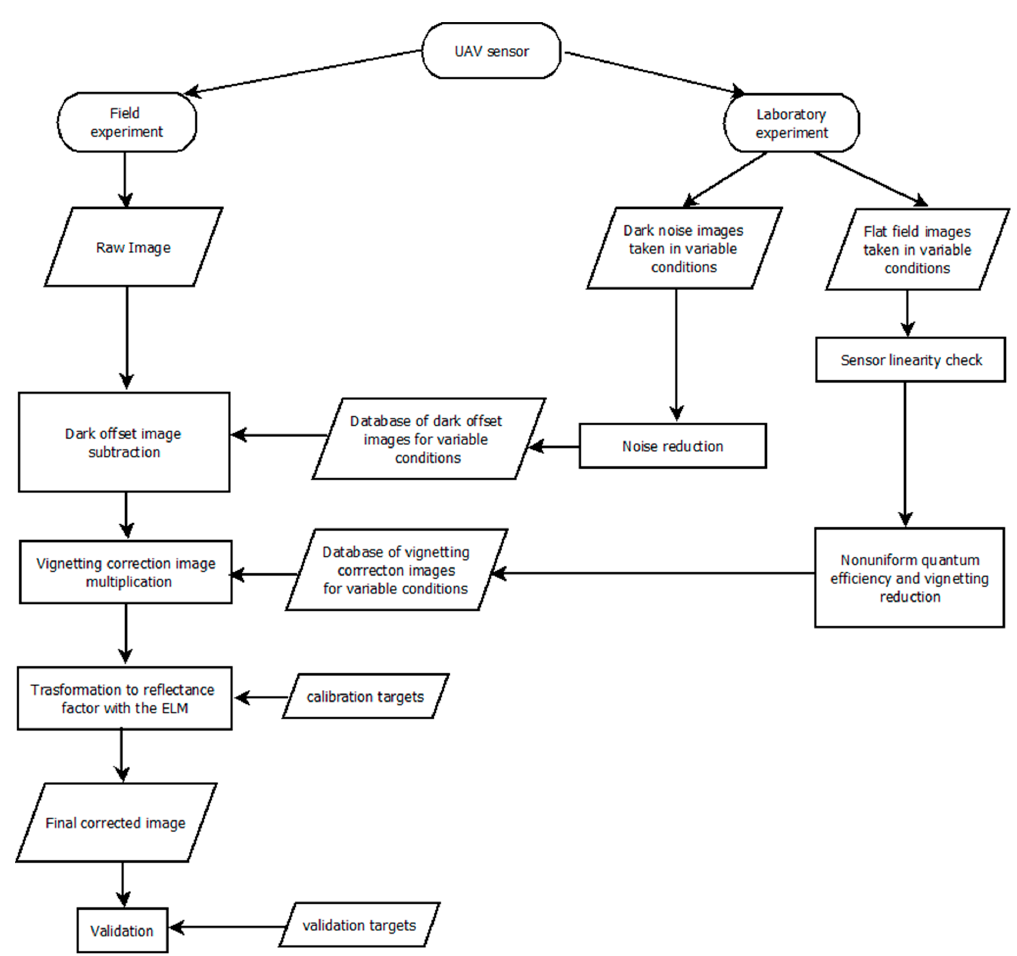
Figure 2. The full data processing workflow proposed in this study to create a reflectance data product.